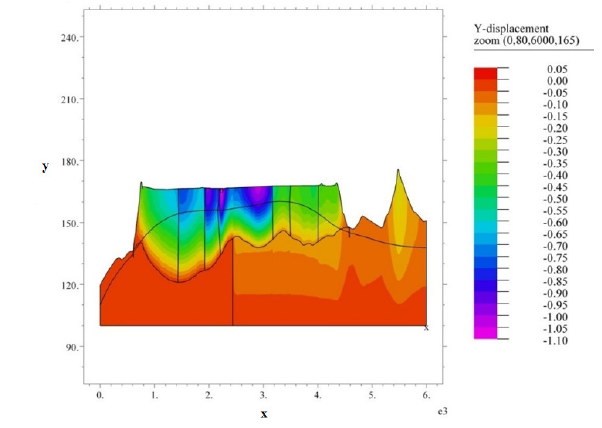
Figure 6: Results for the 2D model – displacement in the y direction.